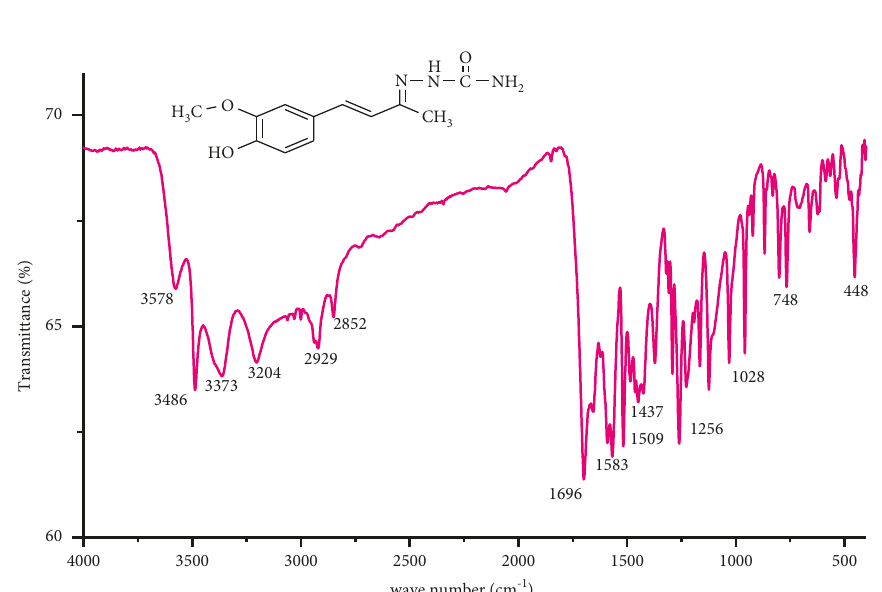
Figure 3: The FT-IR spectra of L